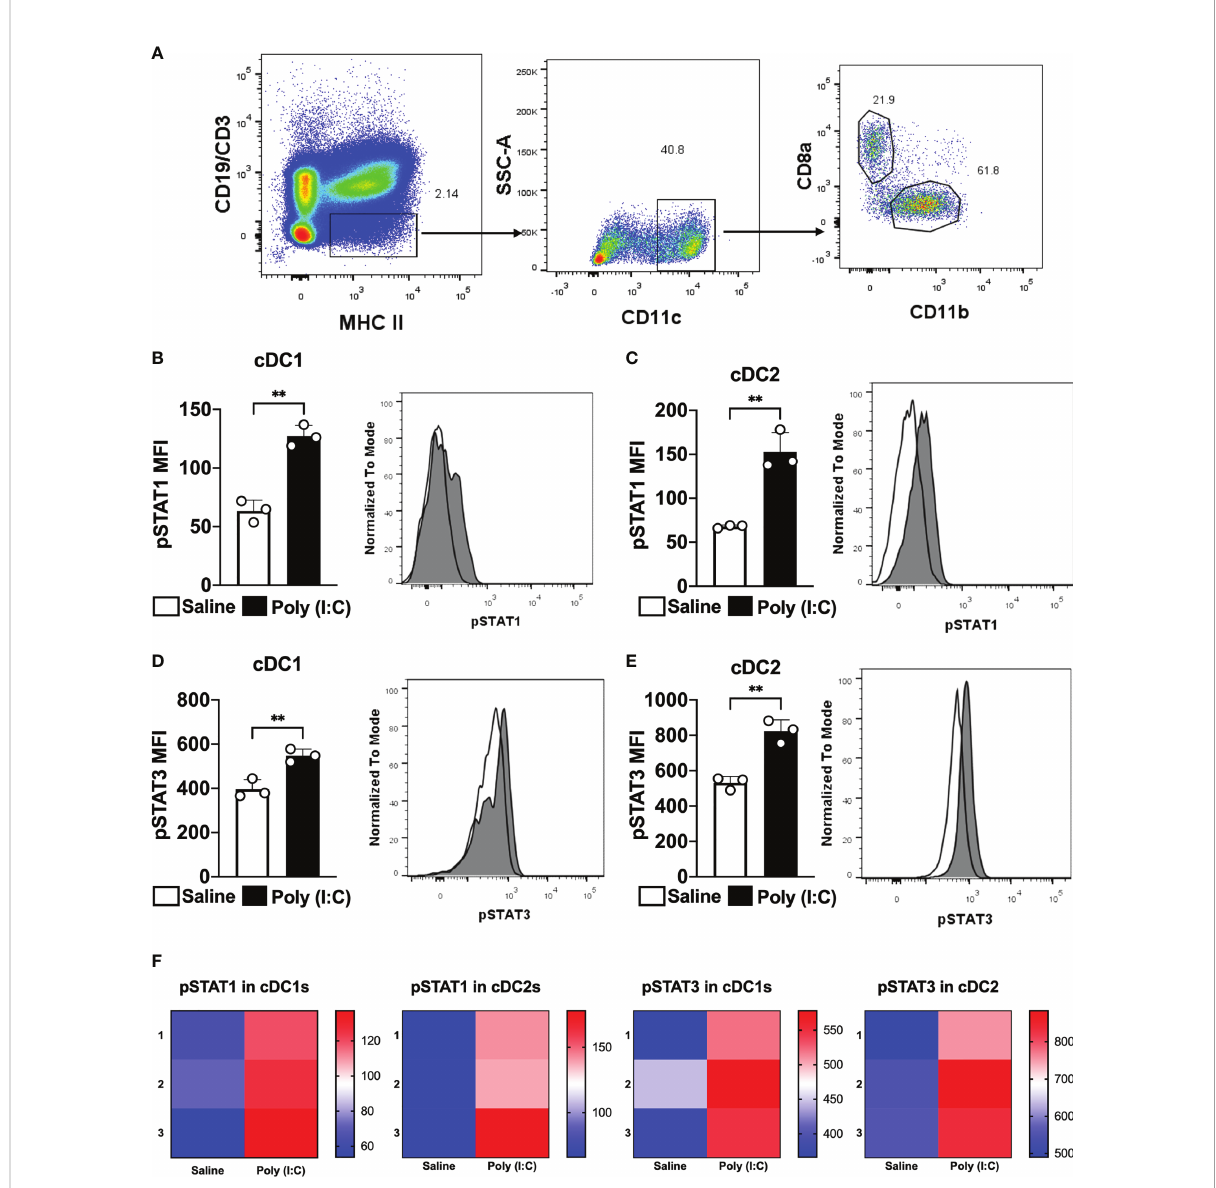
FIGURE 1 Poly (I:C) promotes STAT1 and STAT3 phosphorylation in cDC1 and cDC2. WT C57BL/6 mice were injected intraperitoneally with 50 m g of Poly (I:C) or only saline. Two hours later, splenocytes were obtained. Phosphorylated STAT1 (pSTAT1) and STAT3 (pSTAT3) were analyzed by phos fl ow. (A) Gating strategy to analyze splenic cDC1 and cDC2. Singlets and live cells were gated followed by CD19 - CD3 - MHCII + . Then, CD11c + cells were selected. cDC1 were gated as CD8 a + CD11b - cells and cDC2 as CD8 a - CD11b + . MFI for pSTAT1 is shown in cDC1 (B) and cDC2 (C) . MFI for pSTAT3 is shown in cDC1 (D) and cDC2 (E) . Histograms represent cells from mice injected with saline in white or Poly (I:C) in gray. (F) Heatmaps of pSTAT1 and pSTAT3 MFIs in cDC1 and cDC2 of 3 individual mice. Bars show mean ± SD from one representative experiment (n=3 animals/group) **p<0.01; Student's